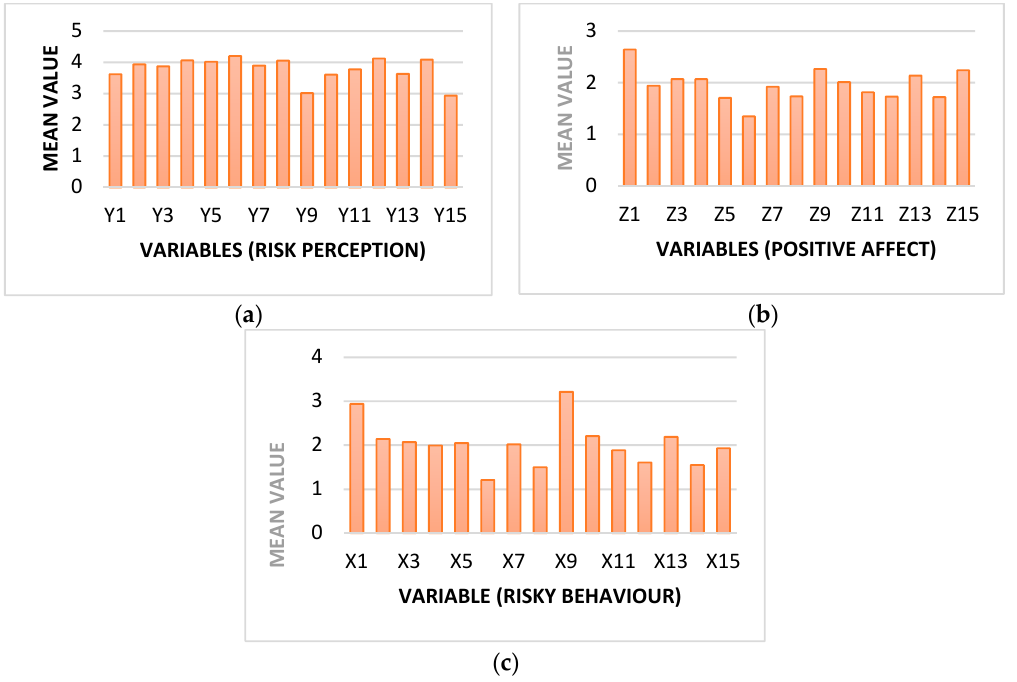
Figure 3. Self-report results (mean value) ( a ) risk perception; ( b ) positive affect; ( c ) risky behavior